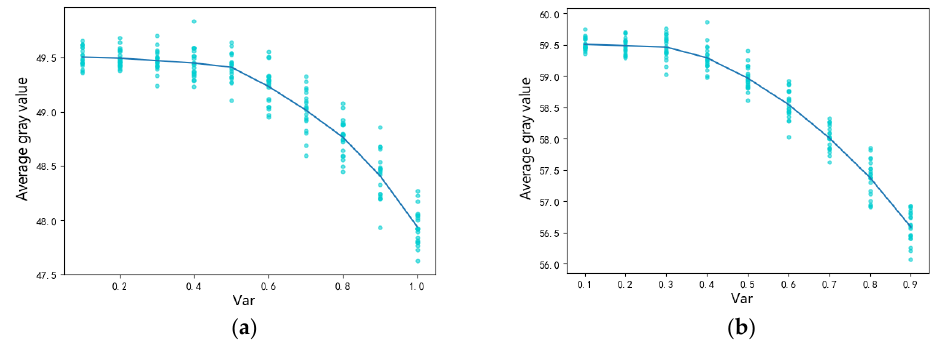
Figure 4. Influence of noise intensity between 0.1–0.9 on image gray value: ( a ) the influence of gamma noise on a gray value of 50 and ( b ) the influence of gamma noise on a gray value of 60. The above conclusions are significant for the biological detection of porous silicon sensors based on quantum dot fluorescence via imaging methods. The inner wall of na- noporous silicon with a Bragg structure used as a biosensor was functionalized in